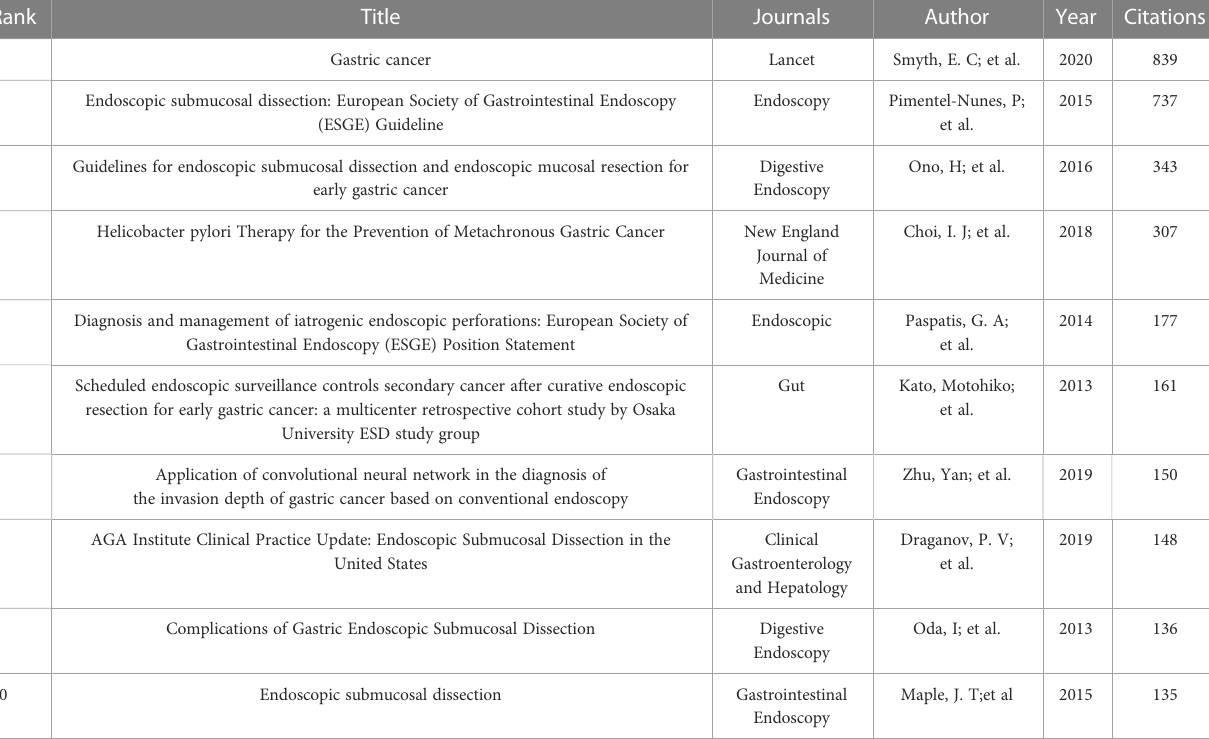
Endoscopic submucosal dissection: European Society of Gastrointestinal Endoscopy (ESGE) Guideline Guidelines for endoscopic submucosal dissection and endoscopic mucosal resection for early gastric cancer